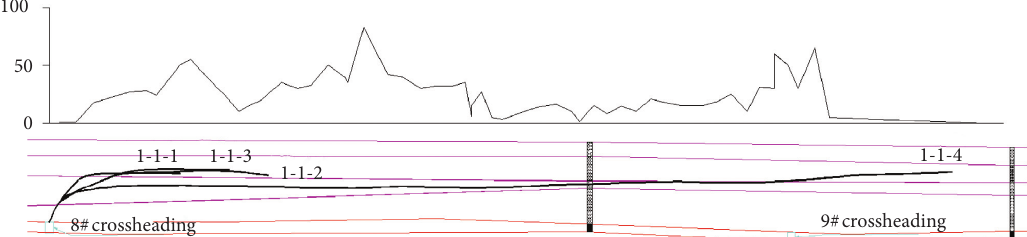
Figure 8: Corresponding figure of extraction concentration of the roof borehole 1-1 and borehole track.